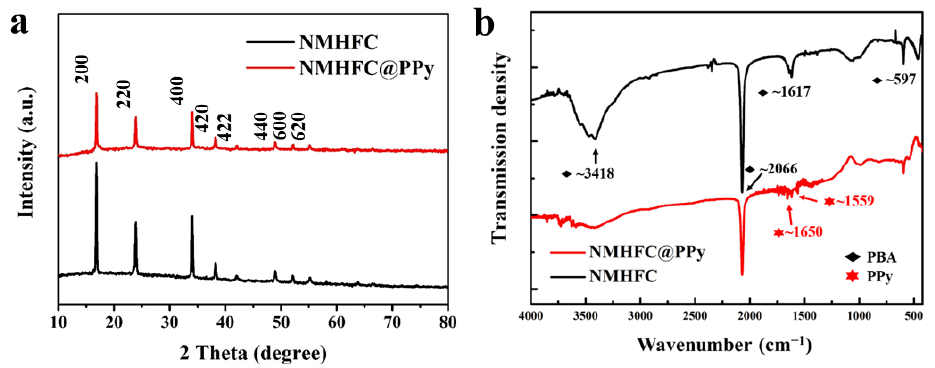
Figure 1. Characterization of as-synthesized NMHFC and NMHFC@PPy. ( a ) XRD patterns, ( b ) FTIR spectra.